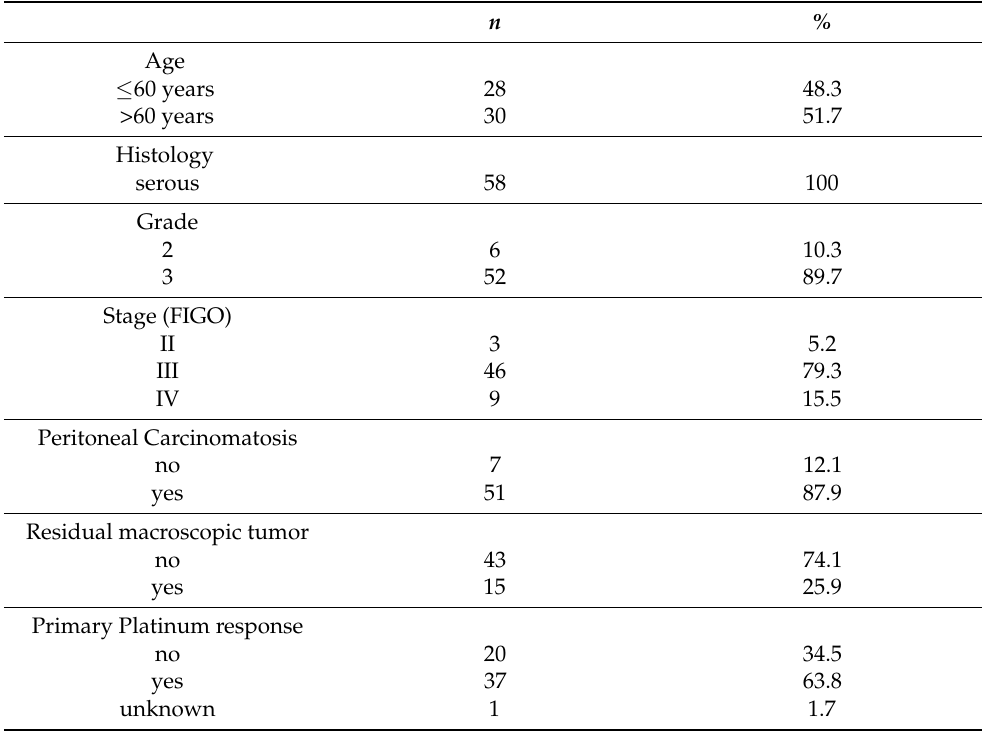
Table 1. Clinico-pathological patient